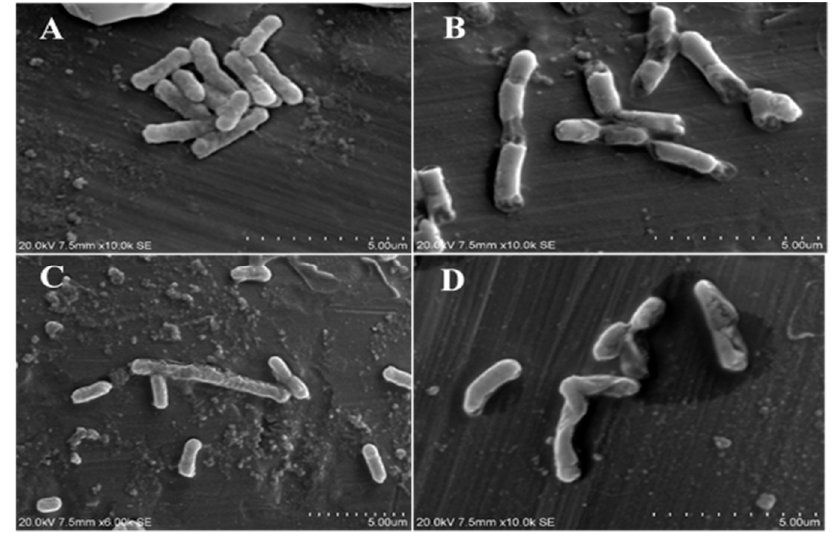
Figure 5. Scanning electron microscope imaging of untreated bacterial cells of ( A ) Salmonella typhimurium (clinical isolates); treated bacterial cells of Salmonella typhimurium (clinical isolate) with ( B ) leaves; ( C ) pods; ( D ) bark extracts of acacia.